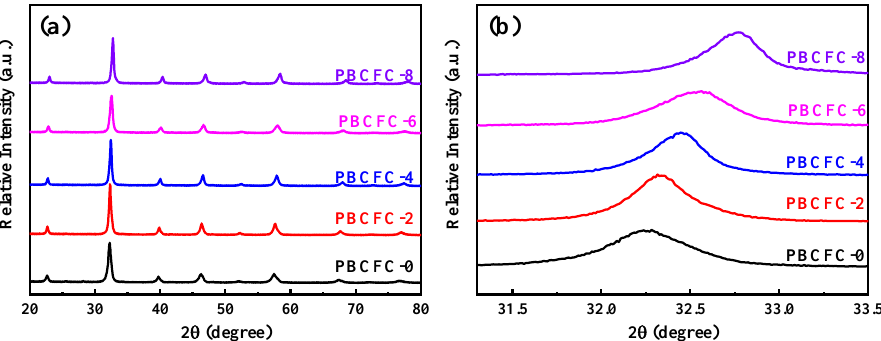
Figure 1. XRD patterns of PBCFC-x (x = 0, 2, 4, 6, 8) ( a ), their magnified diffraction peaks ( b ). SEM images of PBCFC-x (x = 0, 2, 4, 6, 8) powder samples were employed to identify